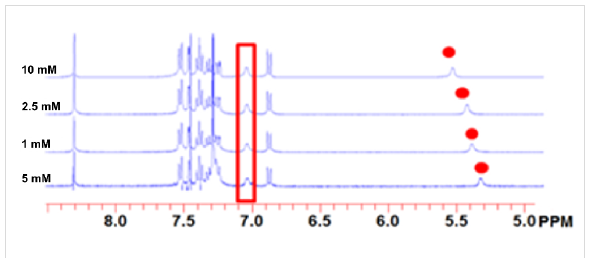
Figure 1: Concentration-dependent 1 H NMR spectra of R - 3 in chloro- form (CDCl 3 ). The red colours indicate the hydrogen resonances of the amide